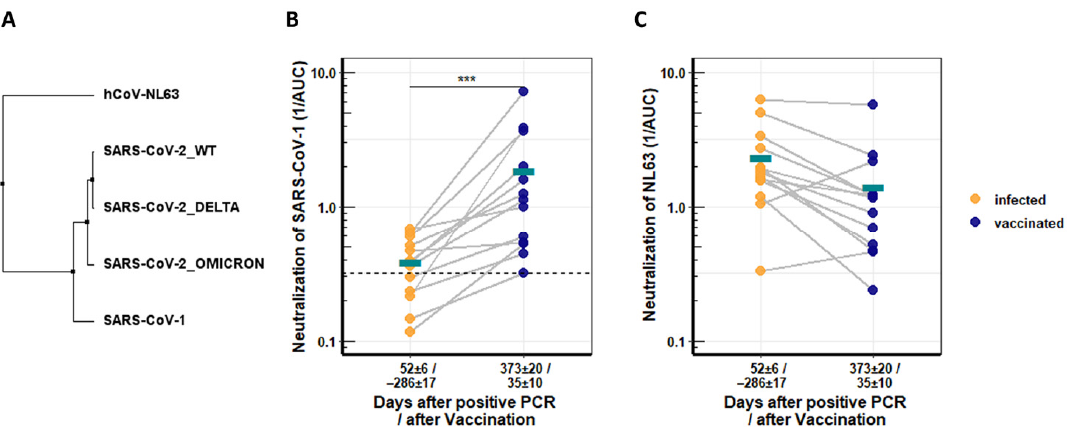
titers were reached for individual patients (Figure 3B).